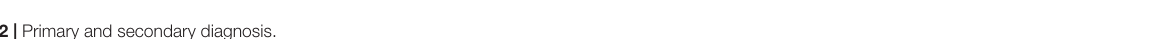
TABLE 2 | Primary and secondary diagnosis.